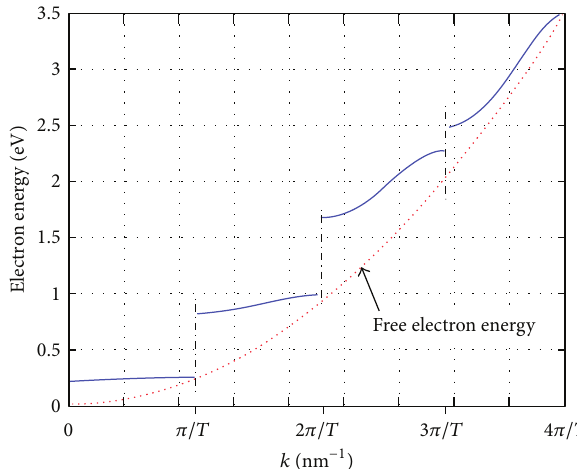
Figure 4: Allowed 𝐸 - 𝑘 states and free electrons energy.